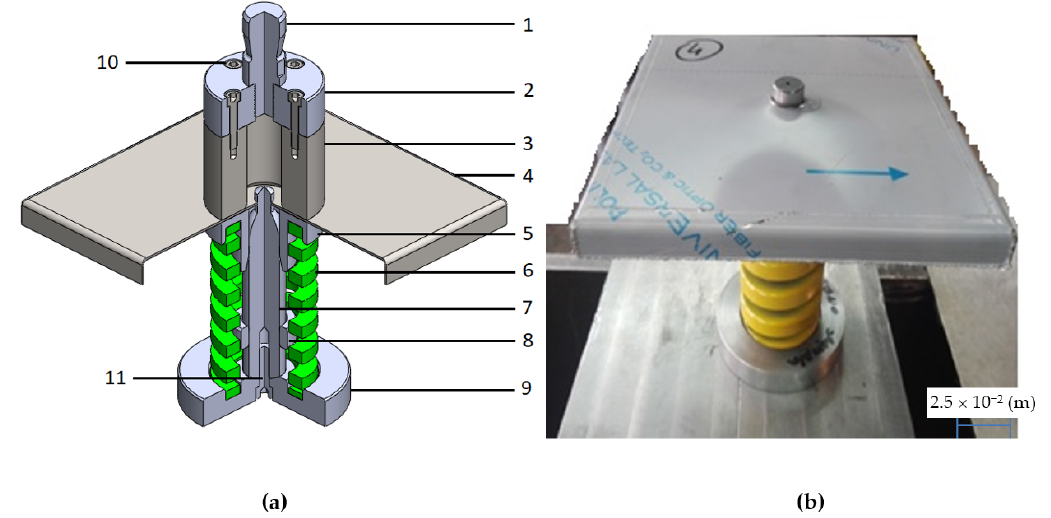
Figure 13. Geometric model of the tool for extrusion of the flange ( a ) and a photo of the flange pressing unit in the plate opening ( b ): 1—die pin, 2—die base, 3—die proper, 4—shaped object (base), 5—holder, 6—holder spring, 7—punch, 8—stop, 9—punch base and spring seat, 10 and 11—fastening elements.